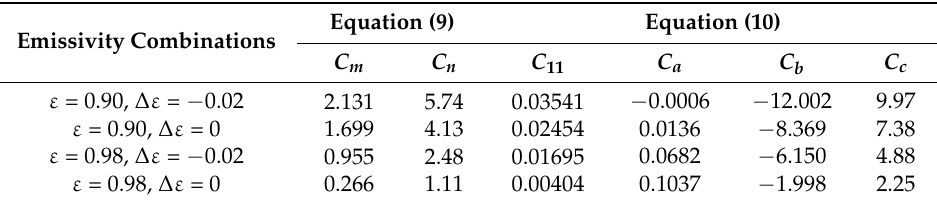
Table 2. C m and C n in Equation (9) and C 11 , C a , C b and C c in Equation (10) for different emissivity combinations.